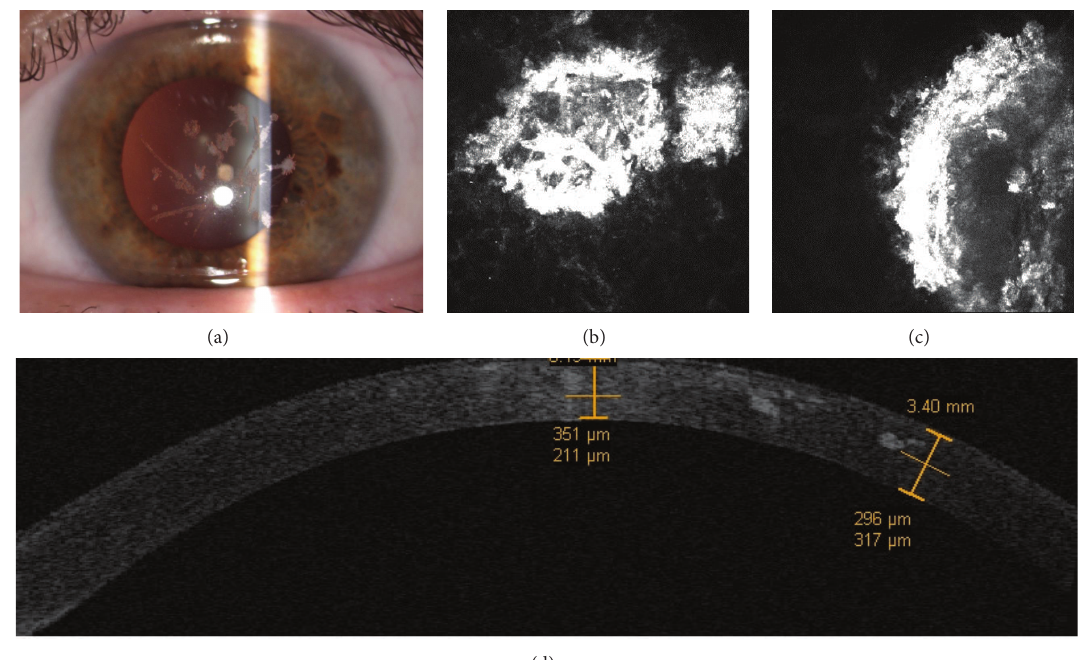
Figure 4: Case 2 , the mother. Slit-lamp examination revealed the presence of bilateral diffuse linear or lattice, granular, and stellate opacities (a). The IVCM evaluation of the mother’s cornea reveals the presence of multiple hyperreflective stellate deposits (maybe of amyloid origin) with needle-shaped dense aspects surrounding low-reflective internal core (maybe of hyaline origin) containing hyperreflective spots (b and c). Time domain OCT corneal scans provided a wide visualization of the cornea revealing the topographic localization and the depth of corneal deposits (d).